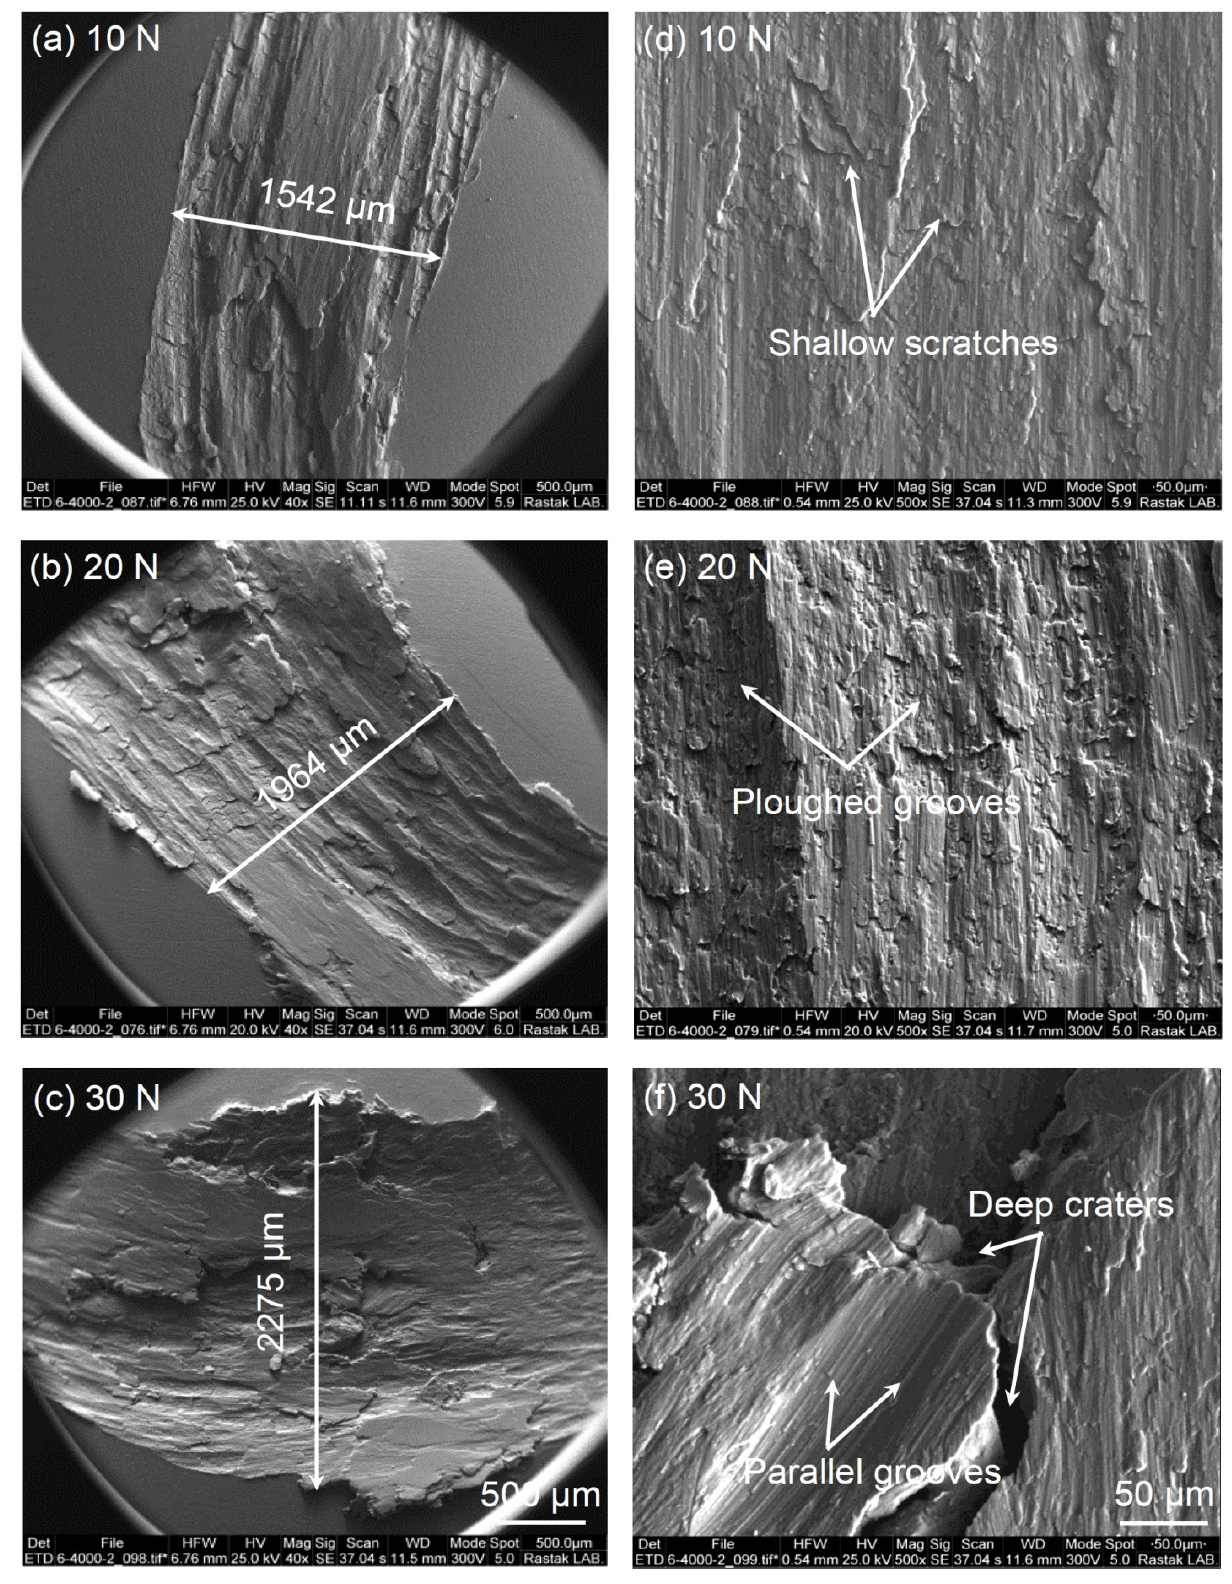
Figure 11. ( a – c ) Low and ( d – f ) high magnification SEM micrographs on worn surfaces of A356 substrate under different applied loads.